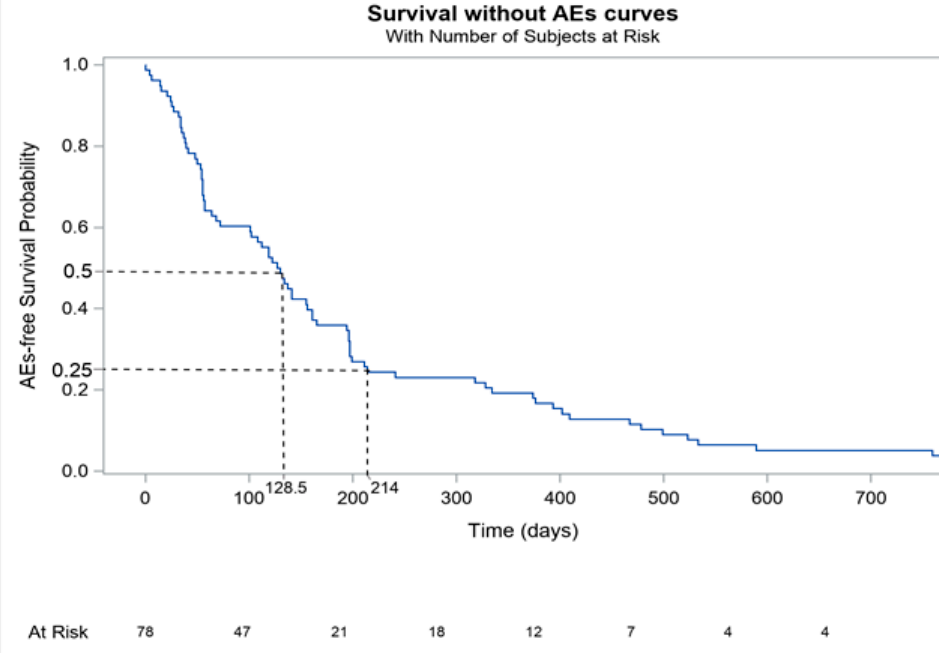
Figure 1. Kaplan–Meier analysis of severe grade III-IV irAEs.